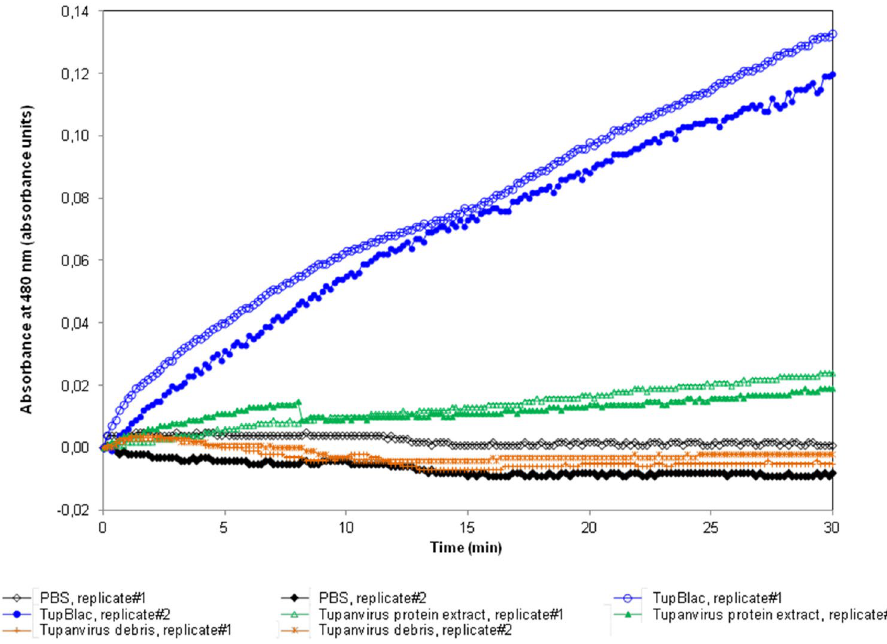
Figure 2. Effect on nitrocefin of expressed Tupanvirus protein (TupBlac). The effect on nitrocefin of the expressed Tupanvirus protein extract (TupBlac) was assessed by monitoring the degradation of nitrocefin, a chromogenic cephalosporin substrate. Tupanvirus protein extract and tupanvirus debris were concurrently tested. PBS, Phosphate-Buffered Saline; TupBlac, tupanvirus expressed